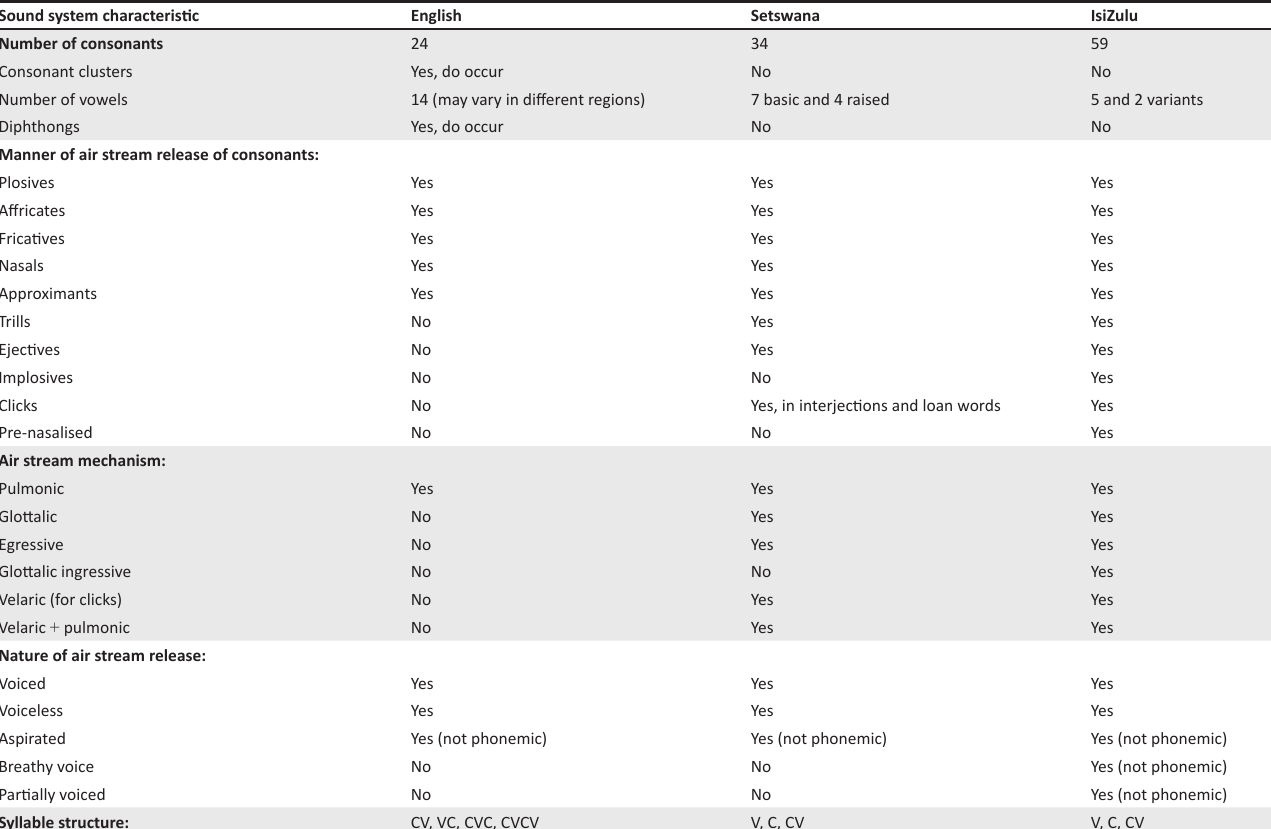
TABLE 1: Occurrence of specific sound system characteristics in English, Setswana, and isiZulu. Sound system